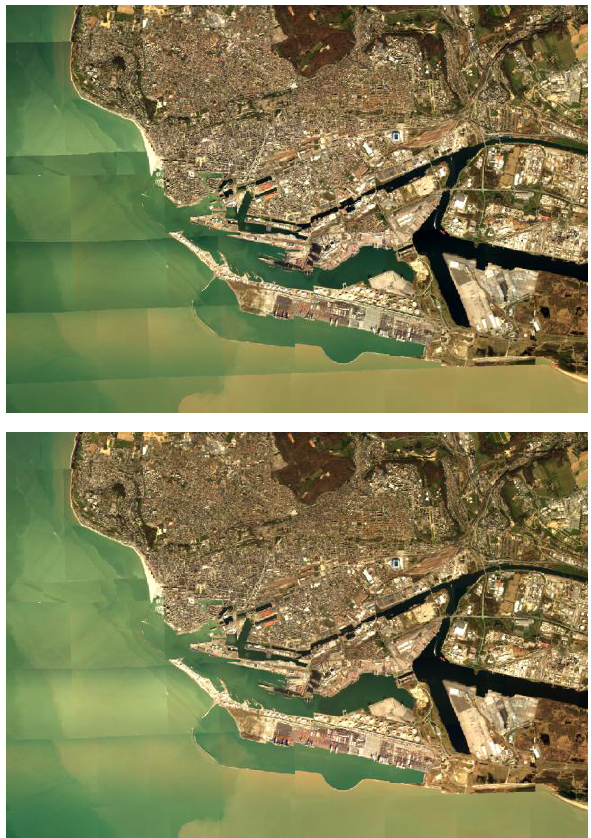
Figure 5. Radiometric normalization of heterogeneous water areas in Le Havre, France. Top: imagery after gradient cor- rection; bottom: final normalization